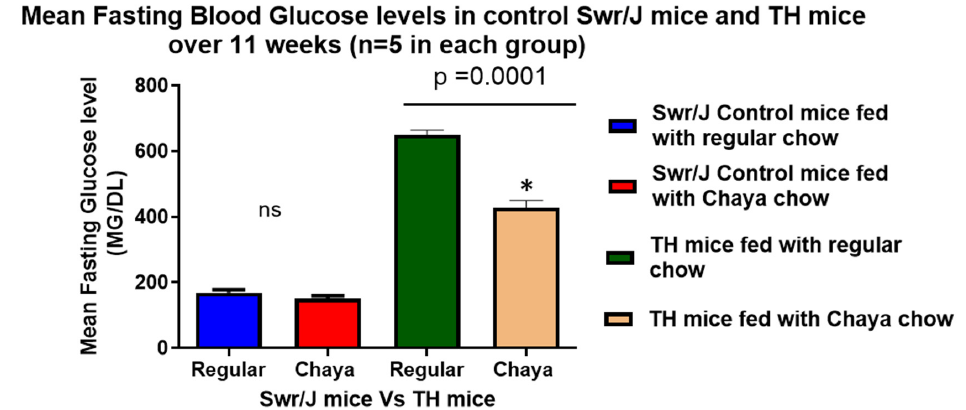
Figure 2. A comparison of the blood glucose levels in the TH mice fed with chaya and TH mice fed with regular chow over a period of 11 weeks ( p < 0.005) in relation to the Swr/J control mice with a statistical significance between the two TH mice groups ( n = 5, p = 0.0001). * p = 0.01.